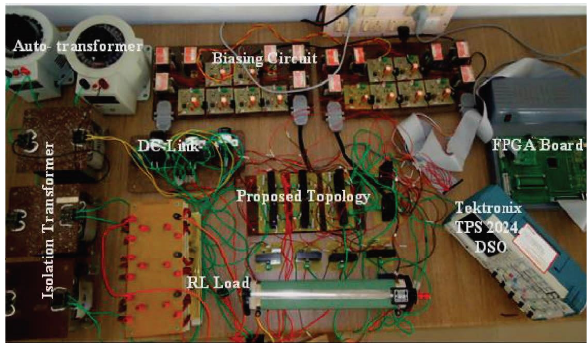
Figure 17: Experimental setup of proposed inverter topology.